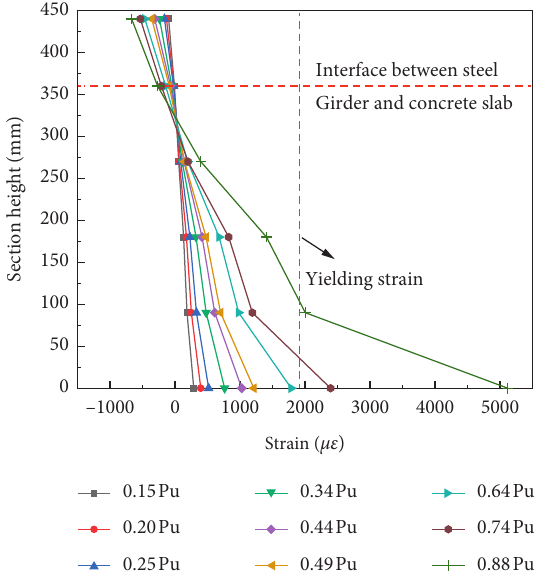
Figure 10: Strain distribution across the composite section height at the loading section (section B) [23].